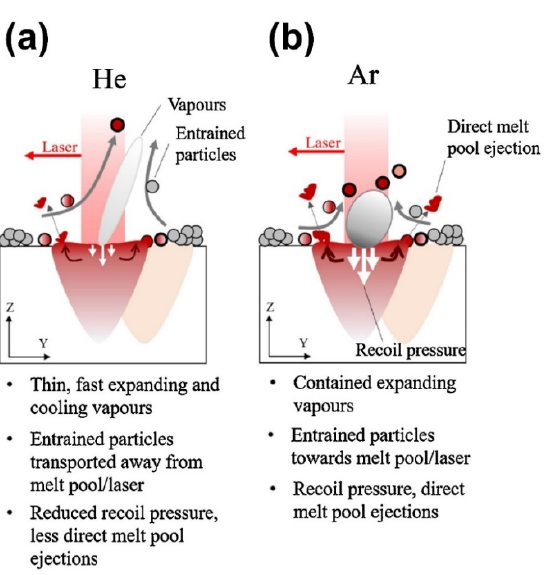
Figure 25. The interaction of the laser–powder bed with (a) Helium and (b) Argon in the L-PBF protective gas. (Reprinted with permission from Ref. [125]. Copyright 2021 CIRP.).